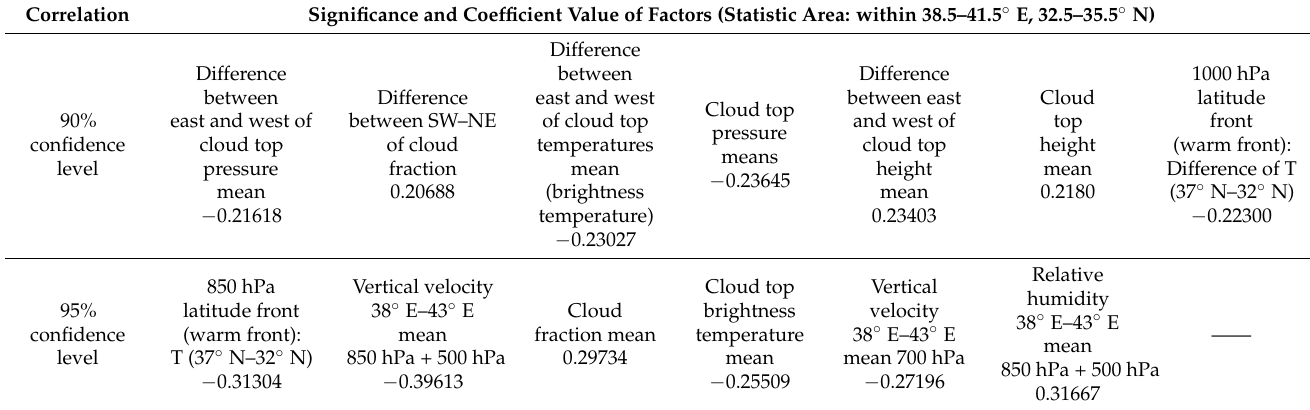
Table 2. Statistical significance of influence factors and their correlation coefficient values at 90% and 95% of confidence.